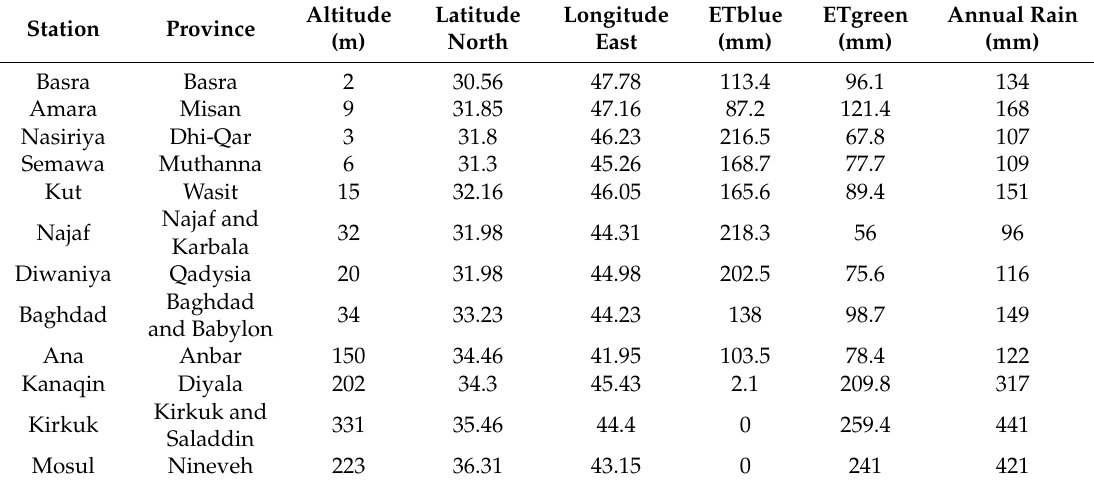
Table 1. Some characteristics of the 12 meteorological